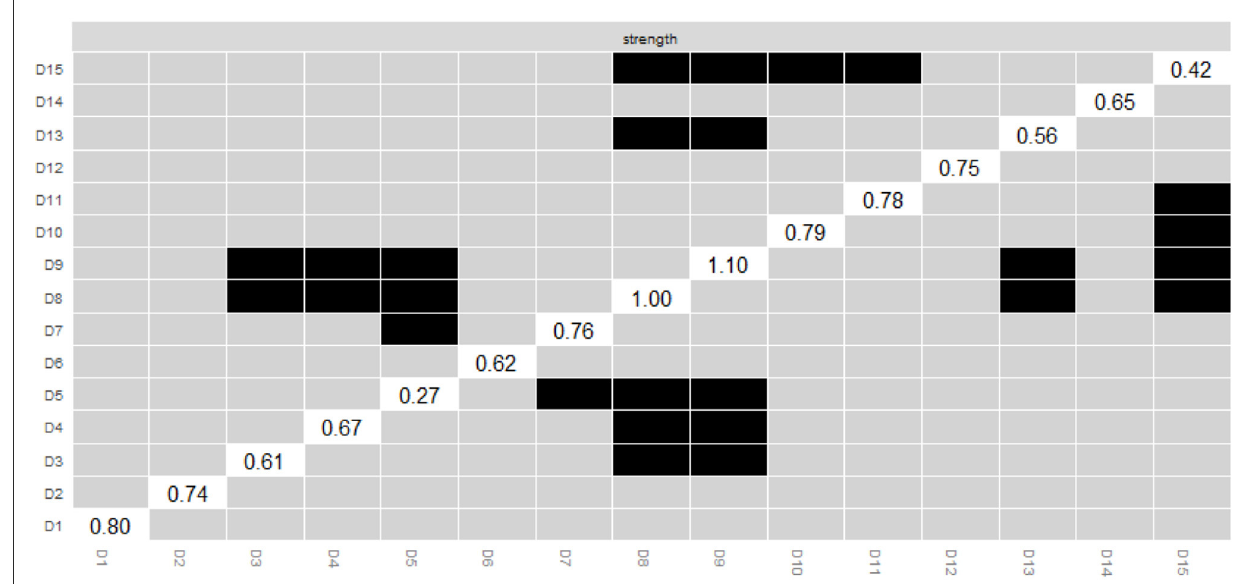
FIGURE6 Estimation of node strength difference by bootstrapped difference test. Bootstrapped difference tests between-node strength of factors. Gray boxes indicate nodes that do not significantly differ from one another. Black boxes represent nodes that differ significantly from one another ( α = 0.05). White boxes show the values of node